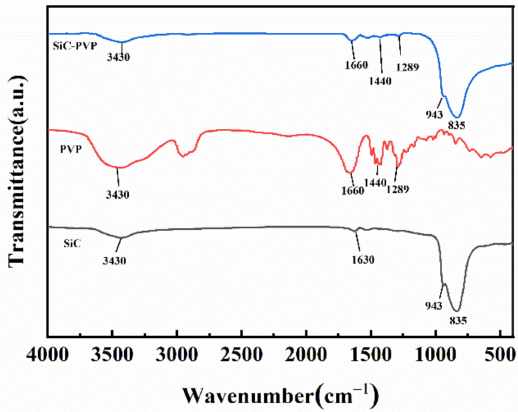
Figure 7. Fourier transform infrared spectroscopy (FTIR) spectra of SiC, PVP, and PVP-adsorbed SiC.